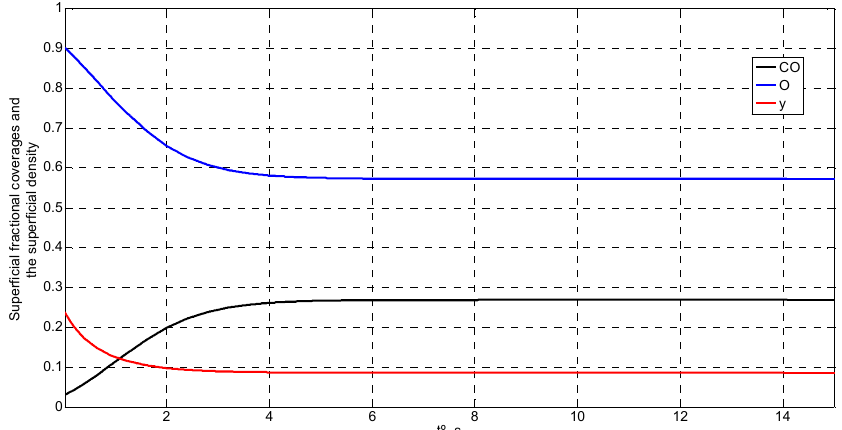
Figure 8. Superficial fractional coverages and the superficial density evolution at P 1 = 39.997 Pa [44].